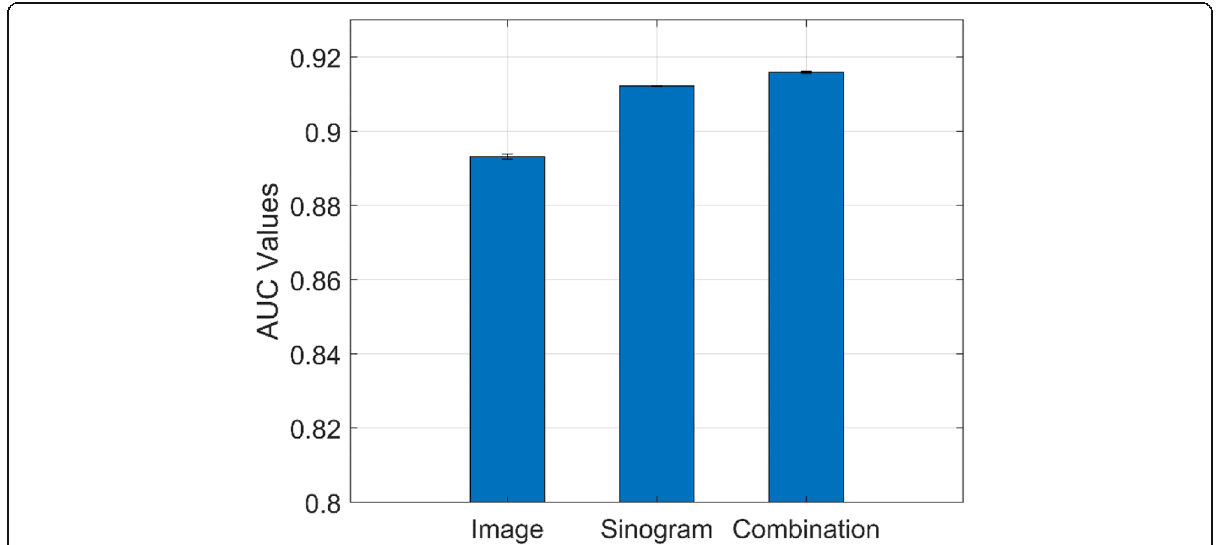
Fig. 8 A comparison of performances via image patch, sinogram, and combination of